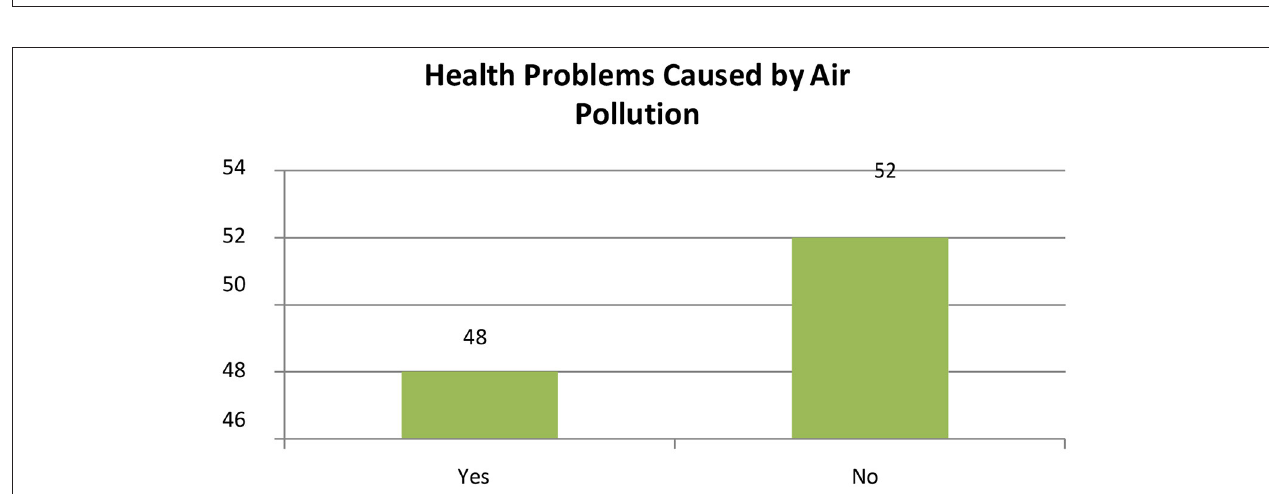
FIGURE 18 | Health problems caused by air pollution compared with last